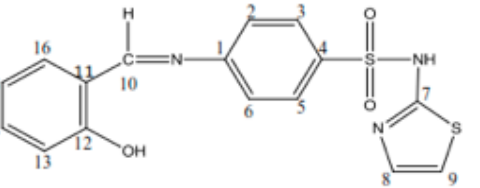
Figure 1. Structural formula with the atom numbering of the Schiff base (HL) ligand.